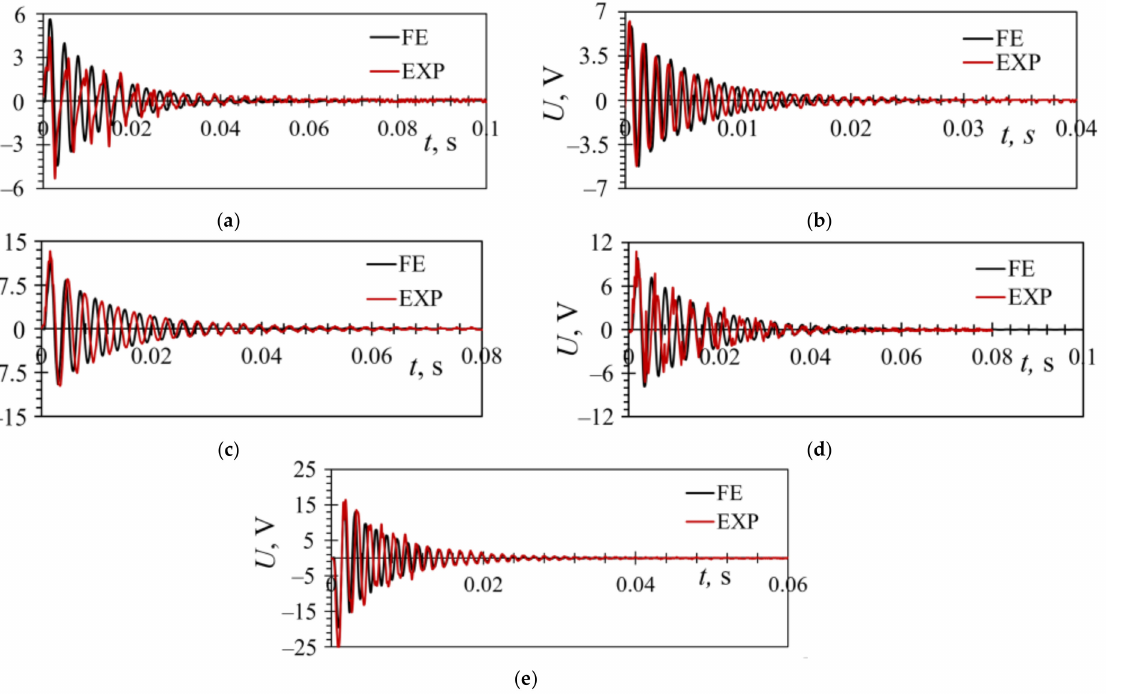
Figure 19. Comparison of experimental and transient FE responses of the PEHs excited by plucking for: an inverted trapezoidal ( a ), a trapezoidal ( b ), a notched ( c ), an inverted wavy trapezoidal ( d ) and a trapezoidal wavy ( e ) bimorph